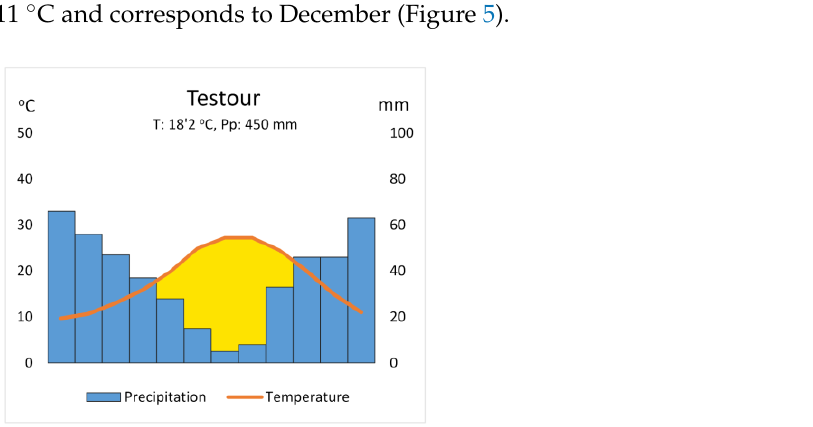
Figure 4. River Medjerda terraces in the vicinity of the pumping station (about two kms downstream from the Sidi Salem dam): (T0) flood zone and river bars; (T1) low terrace (Holocene); (T2) upper Pleistocene terrace; (T3) middle Pleistocene terrace(?). Source: Author.